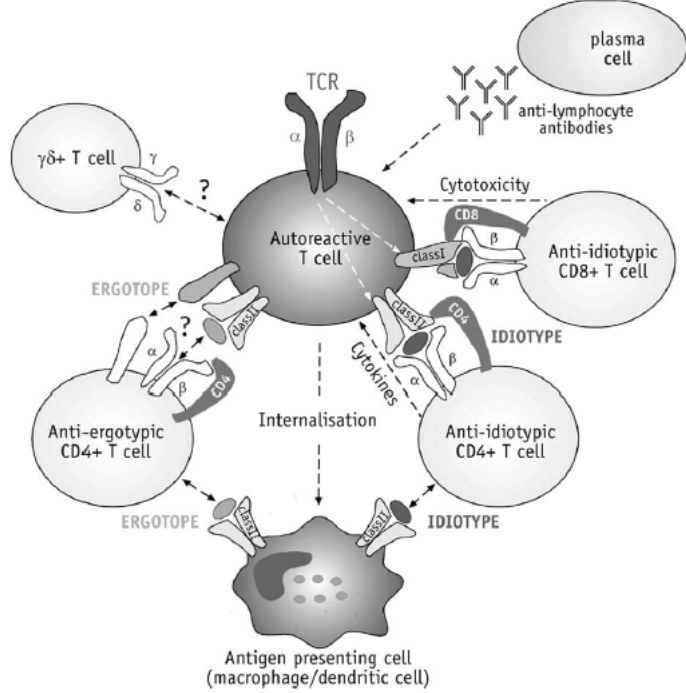
Figure 10. Complexity of anti-vaccine responses induced by TCV (with permission of [29]).